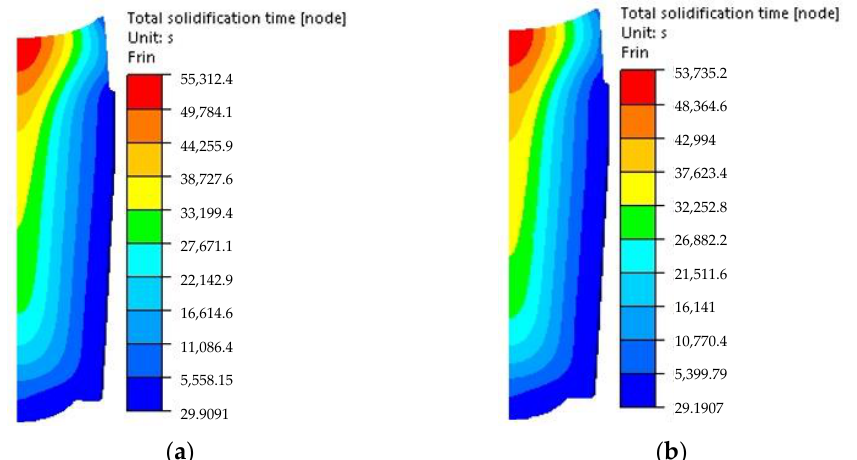
Figure 5. Predicted solidification time: ( a ) 38 M; ( b ) 22 M.